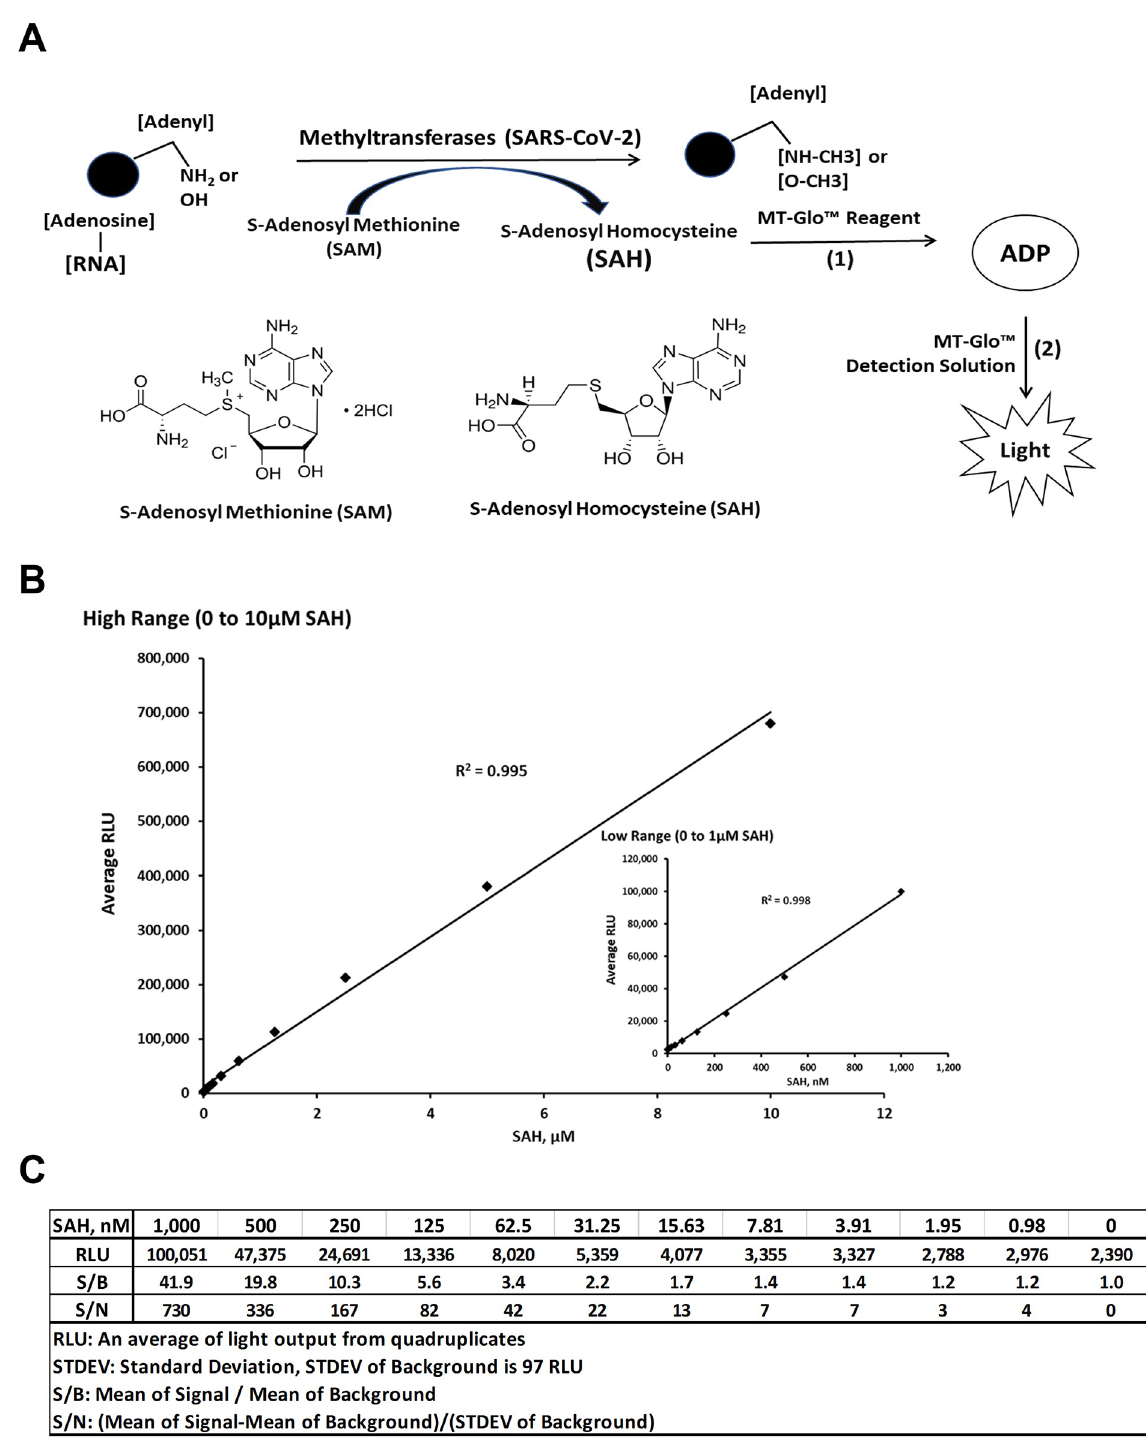
Fig 1. Universal MTase-Glo ™ scheme and sensitivity of SAH detection. (A) Schematic diagram of the basic principle of MTase Glo TM . Basically, any MTase (MTase) that is capable of methylating its substrate and S-Adenosylmethionine (SAM) will generate methylated substrate and S-Adenosylhomocysteine (SAH), the latter is a universal product for all MTases. Conversion of SAH to ADP and to ATP is performed by coupled enzyme reactions. The ATP produced can be quantitated by a luciferase/luciferin bioluminescent reaction. (B) A standard curve showing the relative luminescence units (RLU) in response to SAH concentrations, inset show a lower range of SAH concentration vs. RLUs. Reactions